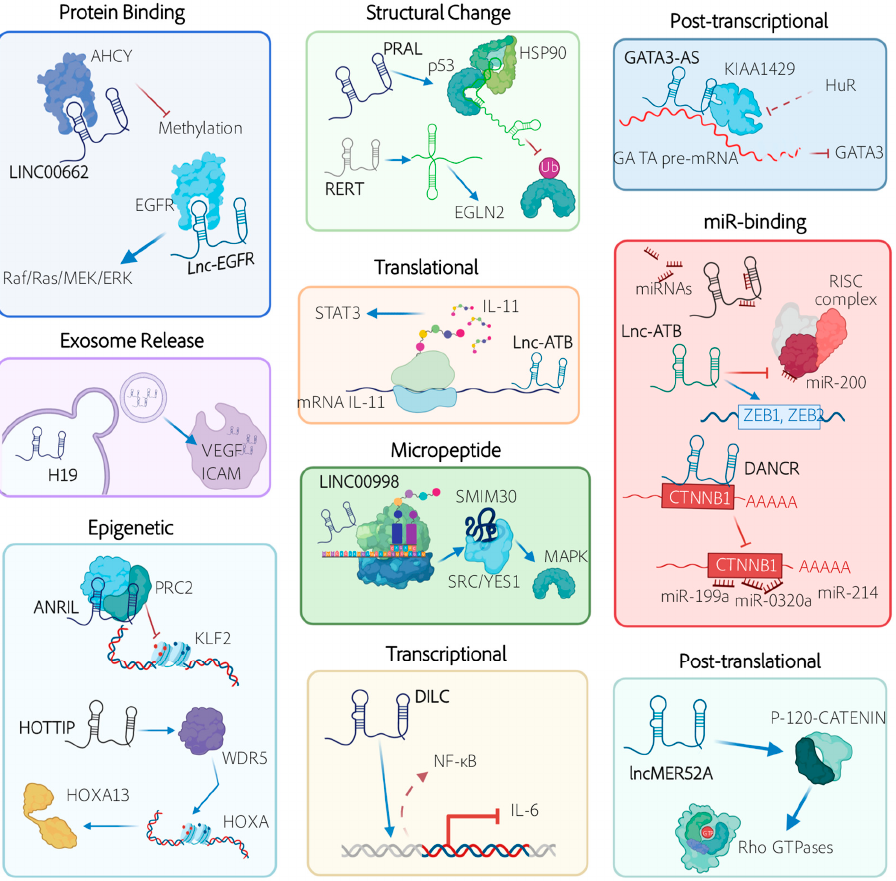
Figure 1. Mechanisms of action enabled by lncRNAs in HCC. LncRNAs can work at several levels to impact HCC development and progression. See text for details. LncRNA-linked blue arrows depict activation while red arrows indicate